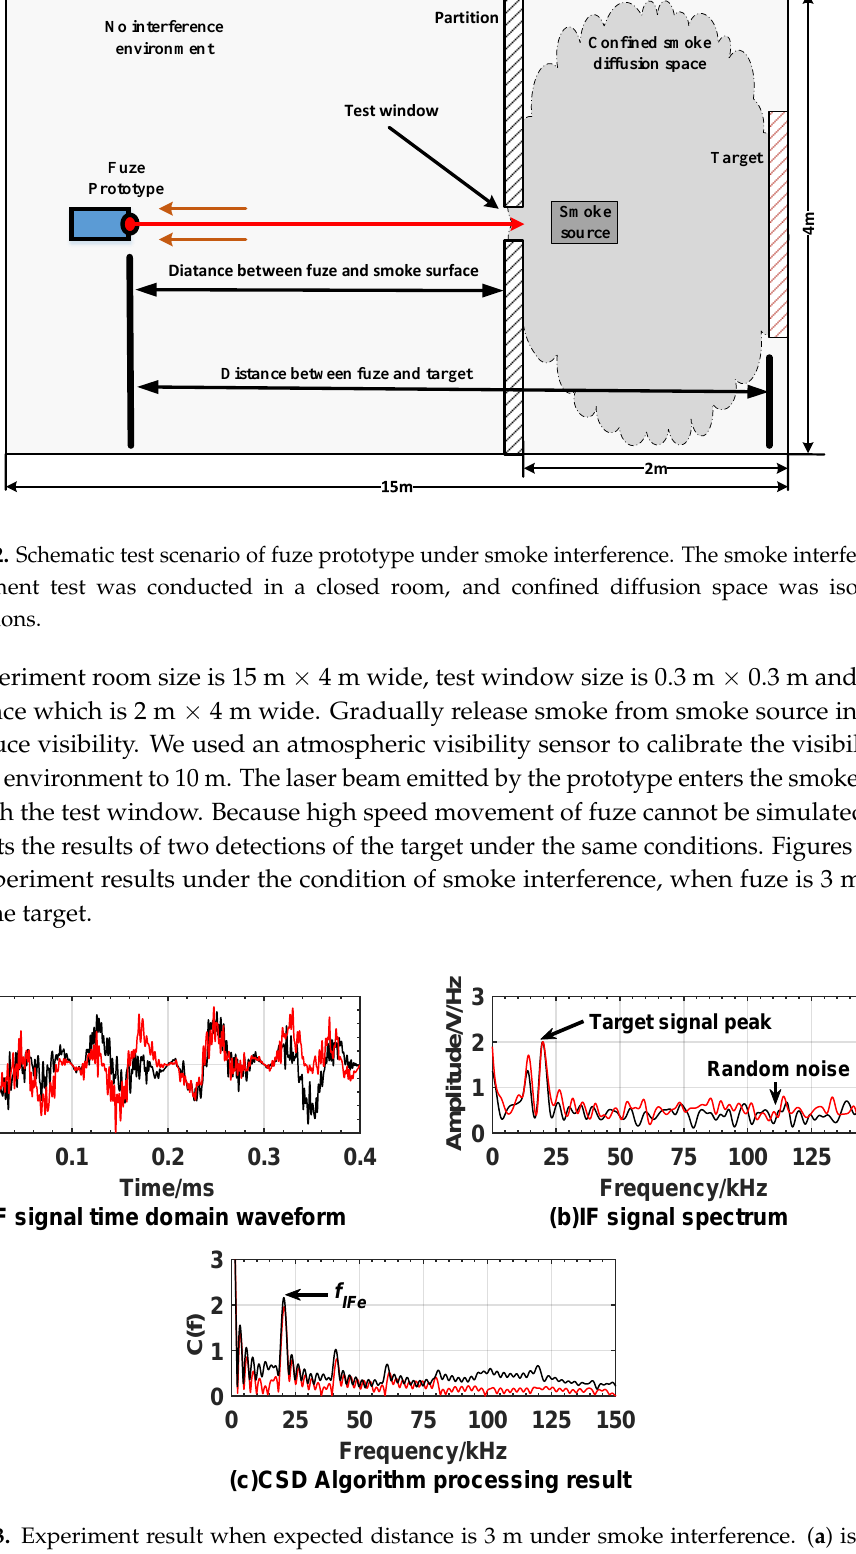
Figure 13. Experiment result when expected distance is 3 m under smoke interference. ( a ) is time domain waveform of IF signal; ( b ) is a spectrum of the IF signal; ( c ) is the processing result of the CSD algorithm. Each simulation result includes two detetions; the red curve represents the first detection, and the black curve represents the second